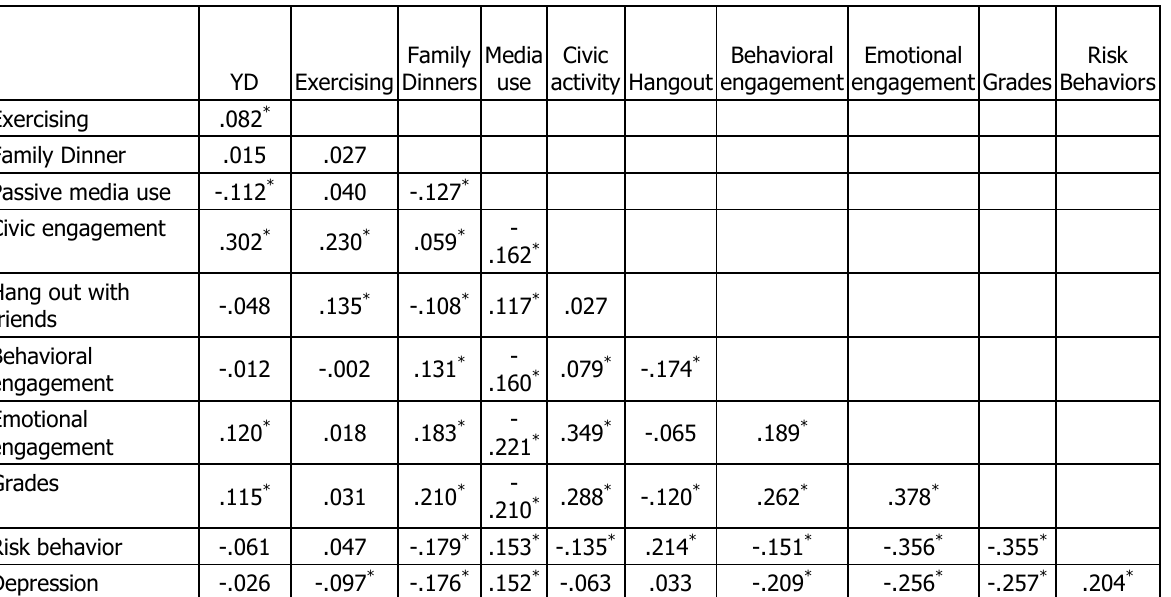
Correlations among activity participation, school engagement, grades, depression, and risk behaviors for Grade